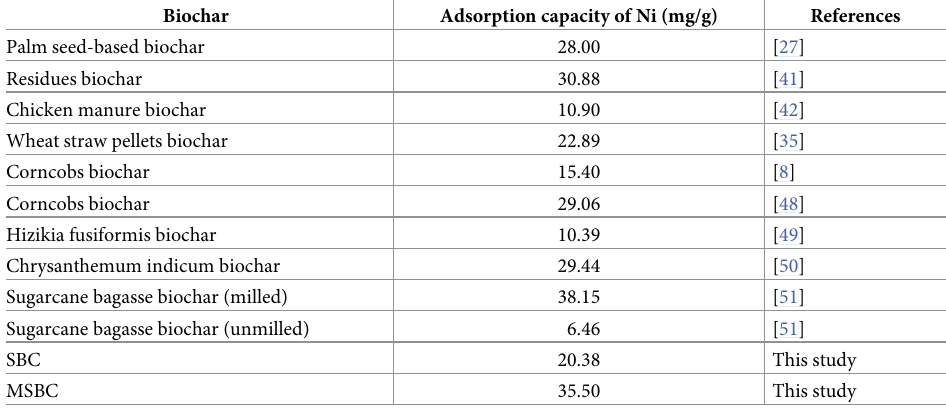
Table 2. Comparison of the maximum adsorption capacity of Ni on SBC, MSBC and various pyrolysis